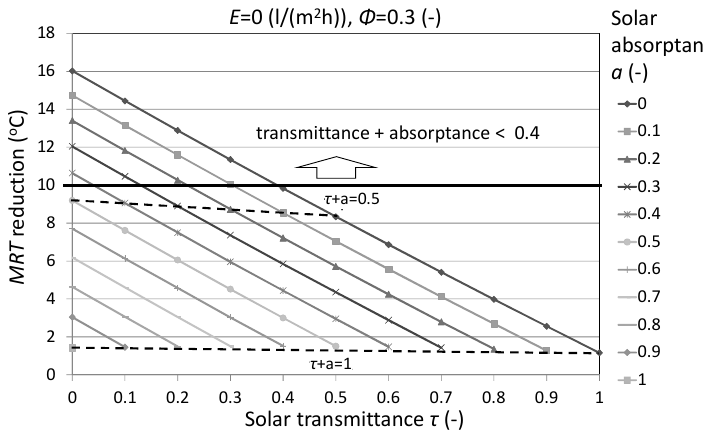
Figure 11. Relationship between the MRT reduction and the solar transmittance τ when the evaporation